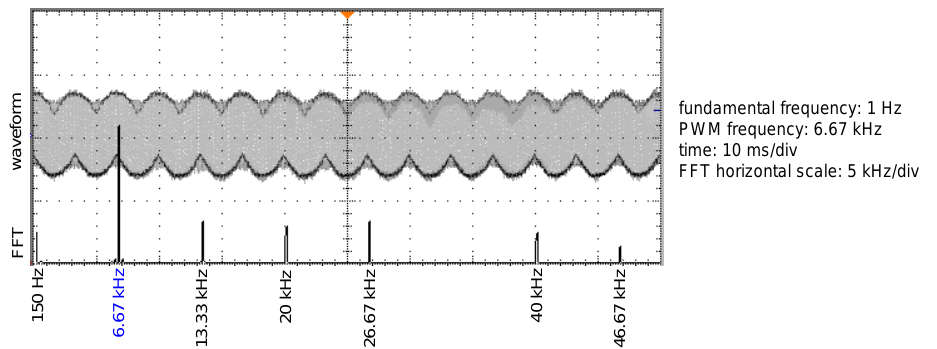
Figure 6. Oscillogram of the earth fault current in a variable-speed drive circuit (earth fault at the motor terminals). The motor is supplied by frequency 1 Hz (very slow motor speed); pulse width modulation (PWM) frequency: 6.67 kHz.